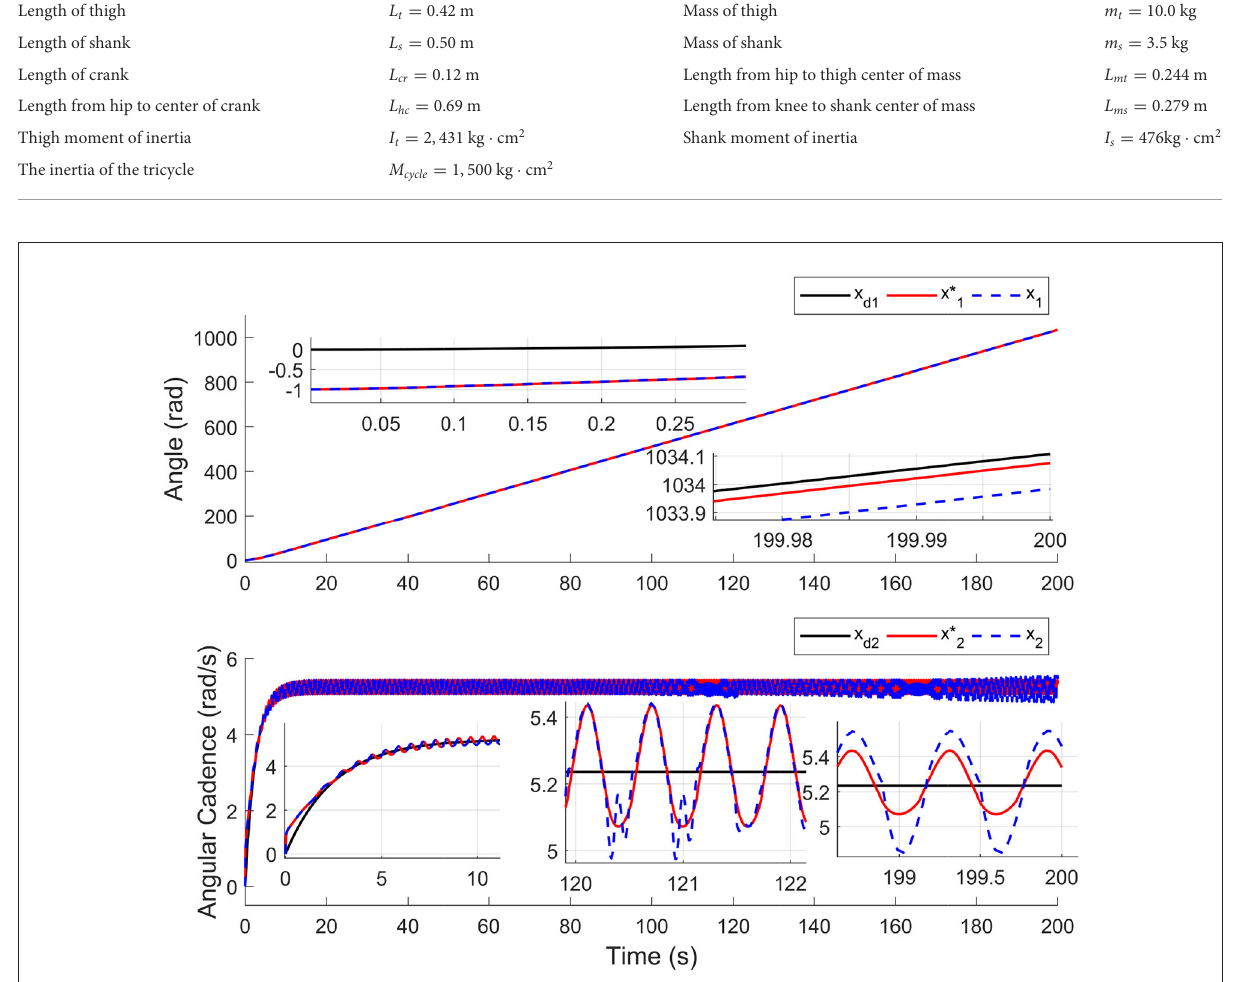
FIGURE2 The tracking performance for nominal system and time delays system. The black solid lines ( x d 1 , x d 2 ), the red solid lines ( x ∗ 1 , x ∗ 2 ), and the blue dotted lines ( x 1 , x 2 ) represent the trajectories of target, nominal system, and time delay system,